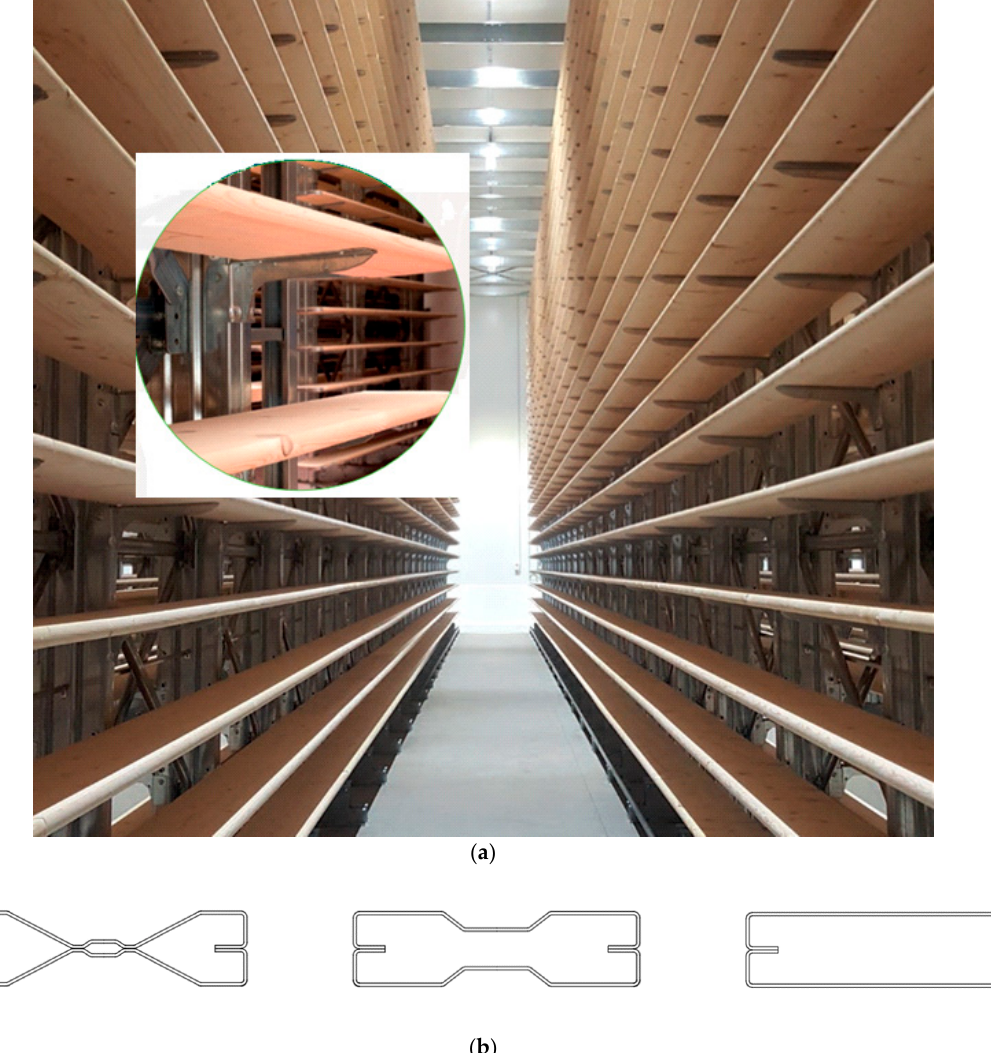
Figure 3. Example of ( a ) the modern steel cold-formed Grana cheese rack [www.dalminels.com] and ( b ) typical composed cross-sections used for columns.